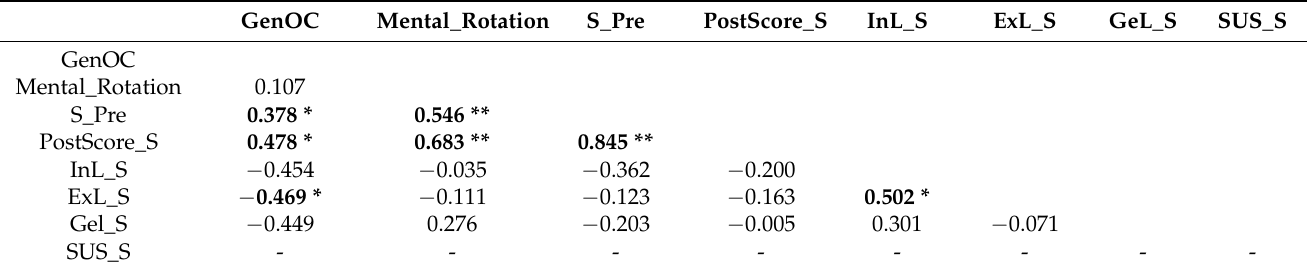
Figure 5. Cognitive load for the topic stereochemistry (n = 41). Table 3. Correlations for group one (non-Augmented Reality (AR)) for the topic stereochemistry.